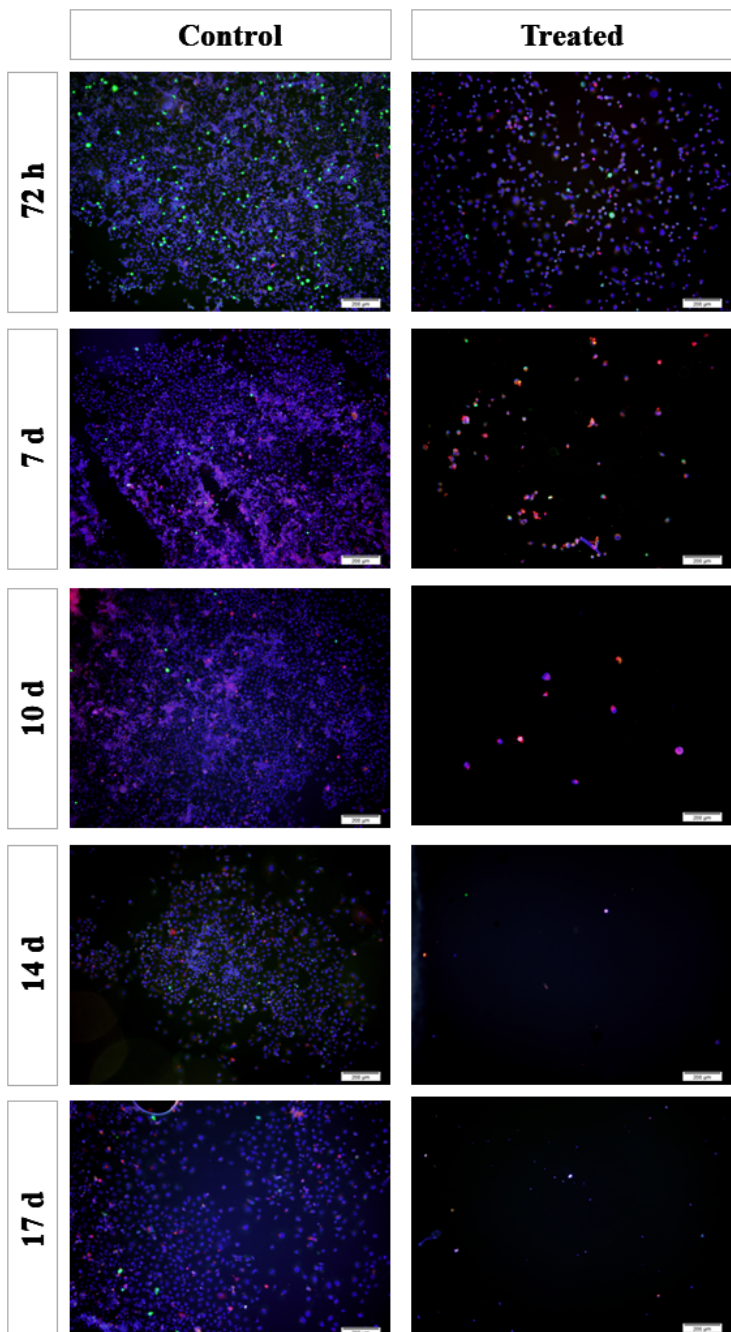
Figure 4. Immunofluorescence staining of the 2D cultures. Blue: cell nucleus (DAPI); red: anti-caspase 3 antibody; green: anti-Ki67 antibody. Scale bar: 200 µm.